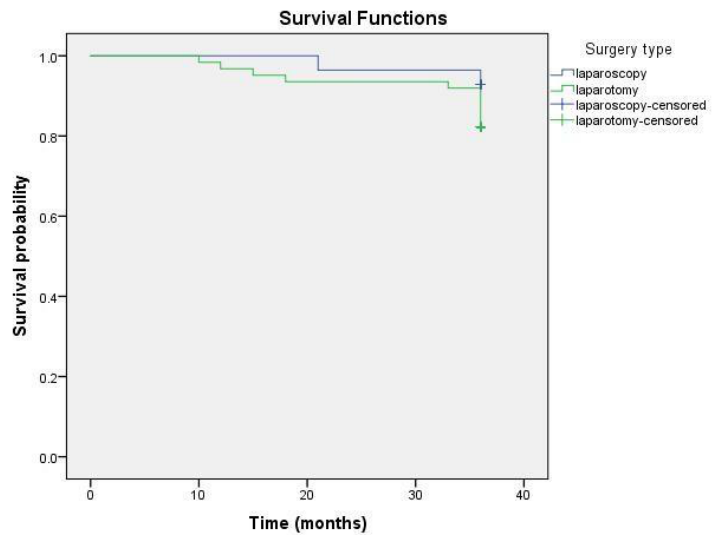
Figure 1. Kaplan–Meier 3-year OS curve of CC patients who underwent the laparoscopic or laparo- Figure 1. Kaplan – Meier 3-year OS curve of CC patients who underwent the laparoscopic or lapa- tomic surgical approach for rotomic surgical approach for RH.